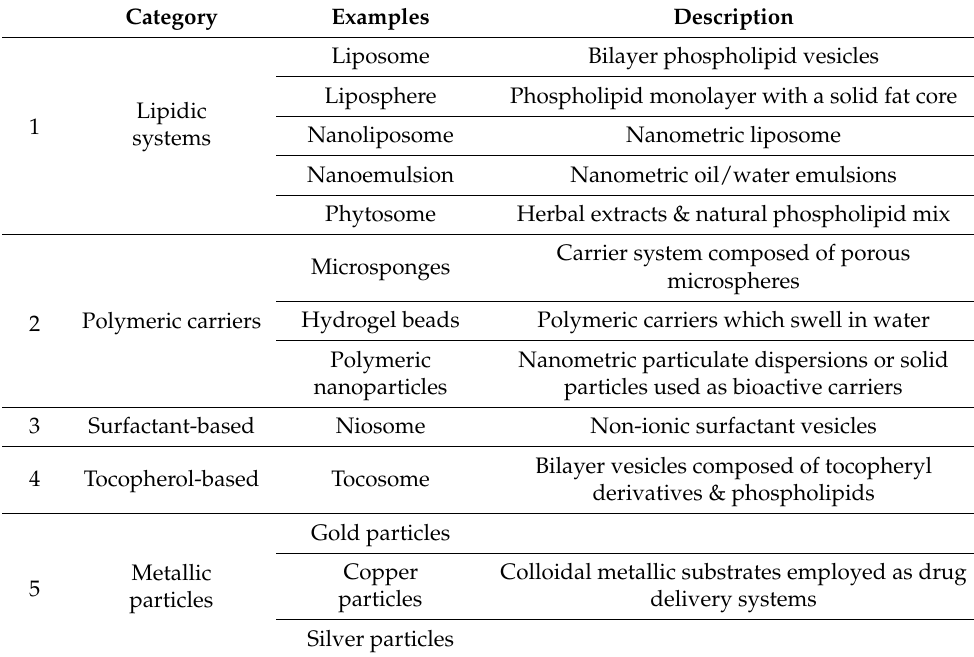
Table 1. Main classes of bioactive encapsulation